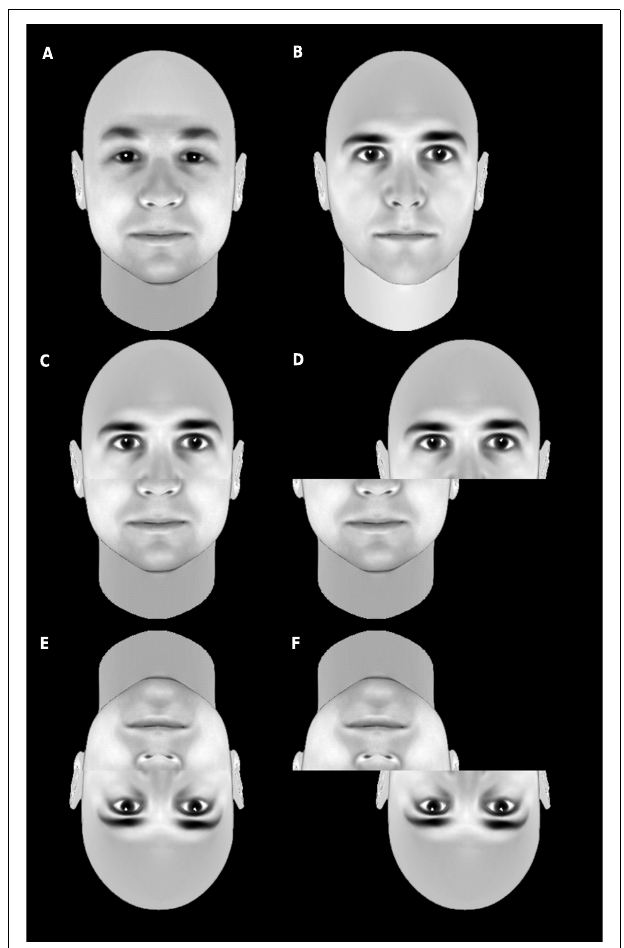
FIGURE 3 | An example of the composite effect . The top row shows two unmodified faces (A,B) . The middle row shows a stimulus composed of the top half of b and the bottom half of a in an aligned condition (D) or a misaligned condition (D) . Recognition of the individual faces that make up the composite is significantly less accurate in the aligned composite (C) than the misaligned non-composite (D) . This difference is less pronounced when the images are inverted (E,F) . This is taken as evidence that faces are normally processed holistically, but that inversion disrupts this holistic